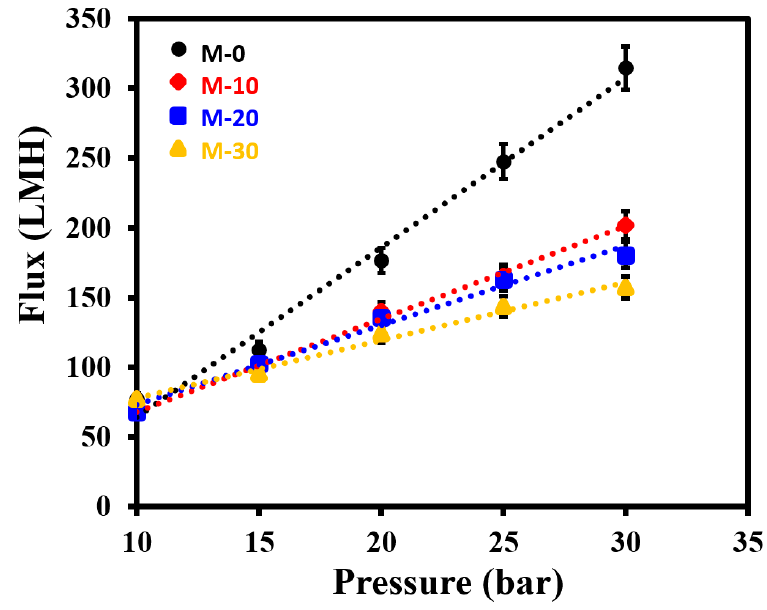
Figure 8. Pure water flux as a function of applied pressure for the original and modified membranes.